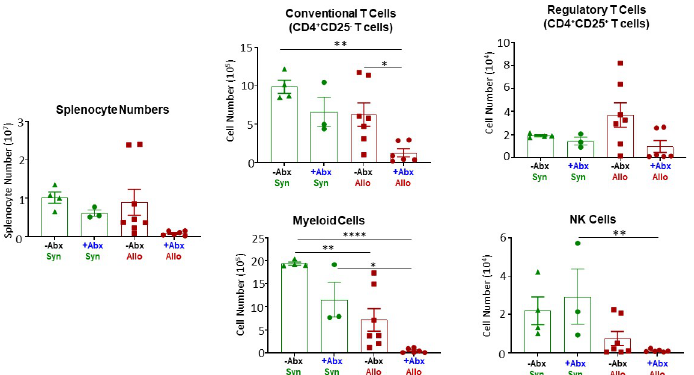
Fig 4. Acute GVHD-induced spleen hypoplasia. Spleen weights, splenocyte numbers and spleen-residing immune cells were quantified at 4 weeks post T cell transfer for mice in the 4 groups described in Fig 1. Conventional (CD4 + CD25 - ) T cells, regulatory T cells (Tregs; CD4 + CD25 + ), myeloid (CD11b + ) cells and NK (CD335 + ) cells were quantified by flow cytometry. Asterisks ( � ) designate significant differences between groups. ( � p < 0.05, �� p < 0.01, ���� p < 0.0001).